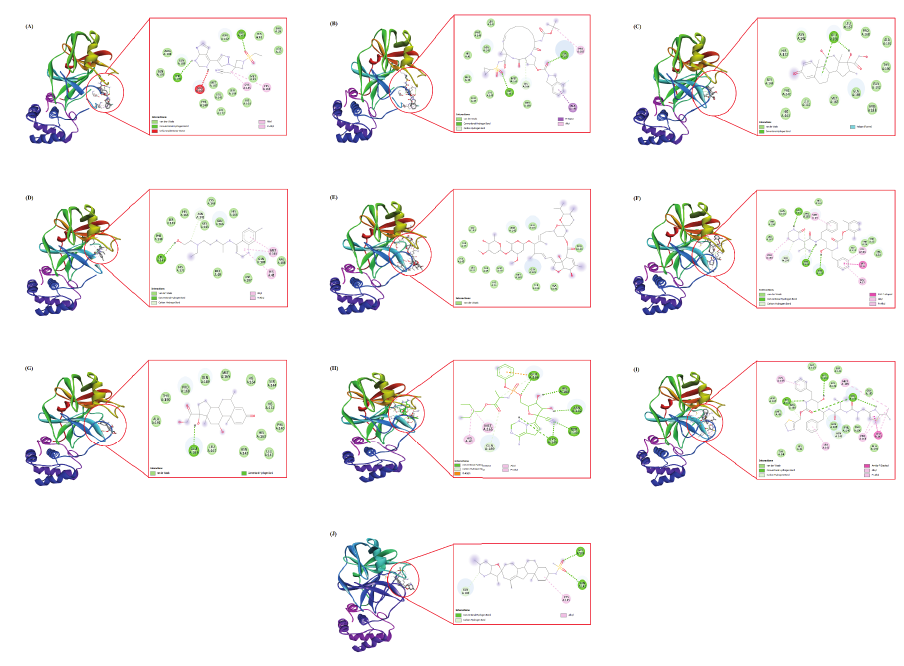
Figure 2 : Molecular interaction of (A) baricitinib, (B) danoprevir, (C) dexamethasone, (D) hydroxychloroquine, (E) ivermectin, (F) lopinavir, (G) methylprednisolone, (H) remdesivir, (I) ritonavir, and (J) saridegib against SARS-CoV-2 main protease (Mpro).